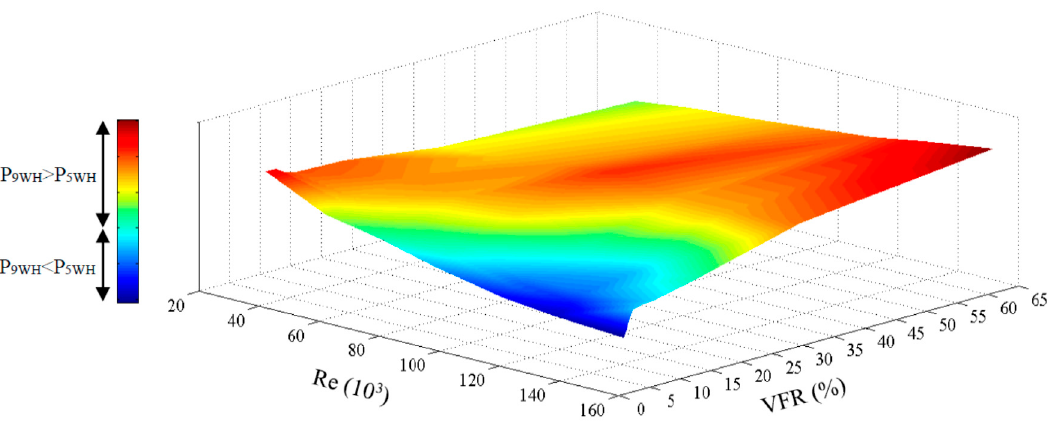
Figure 4. Comparison between the first peak for 5WH and 9WH as a function of Re and VFR.